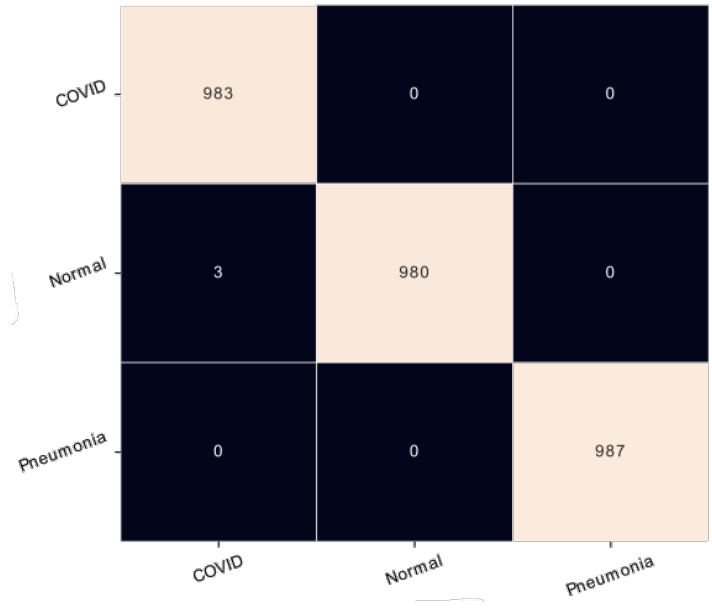
Figure 6. Confusion matrix of CT scan modality. Table 7. The classification report of our proposed approach on CT scan modality.